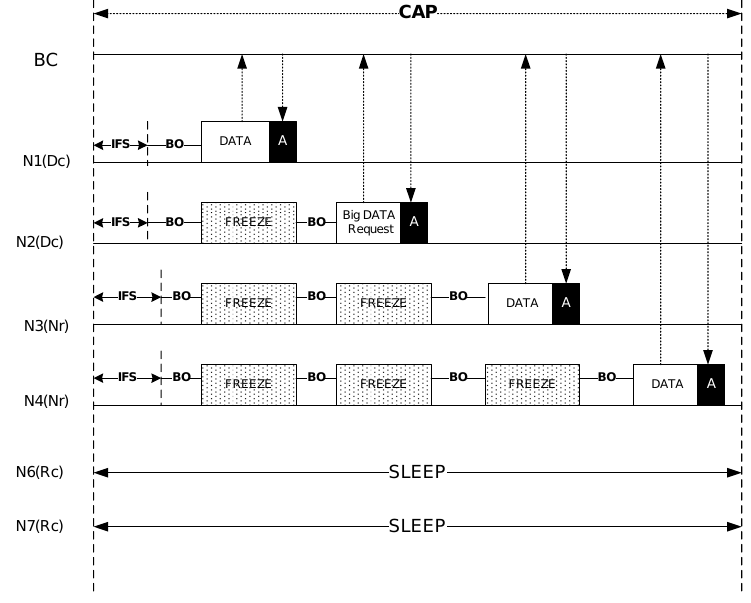
Figure 6. Communication during Contention Access Period